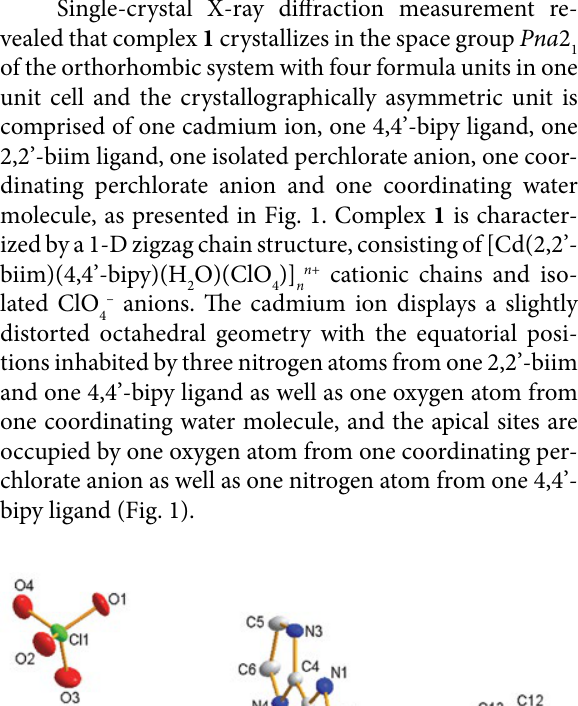
Figure 2. The 1-D zigzag chain structure of complex 1 .